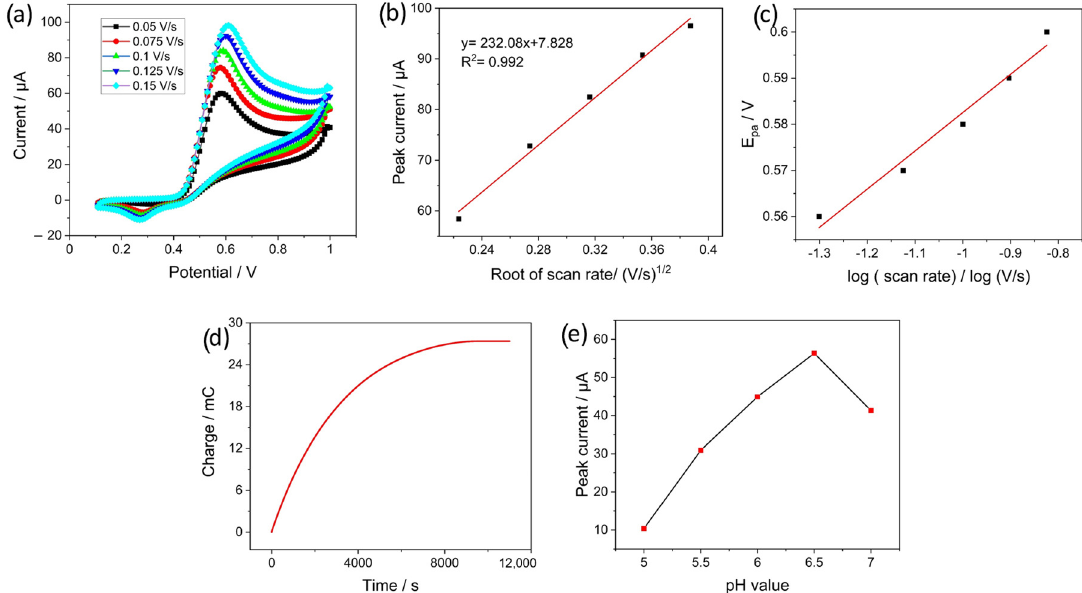
Figure 6. CV curves for ( a ) investigation of the oxidation mechanism of nitrite on EdAu electrode, ( b ) plot of peak current from CV versus root of scan rate; ( c ) Tafel plot obtained from the peak potential from CV at different scan rates, ( d ) the charge consumed during bulk electrolysis for 250 µM of nitrite, and ( e ) the role of pH in the electrocatalytic oxidation of nitrite.